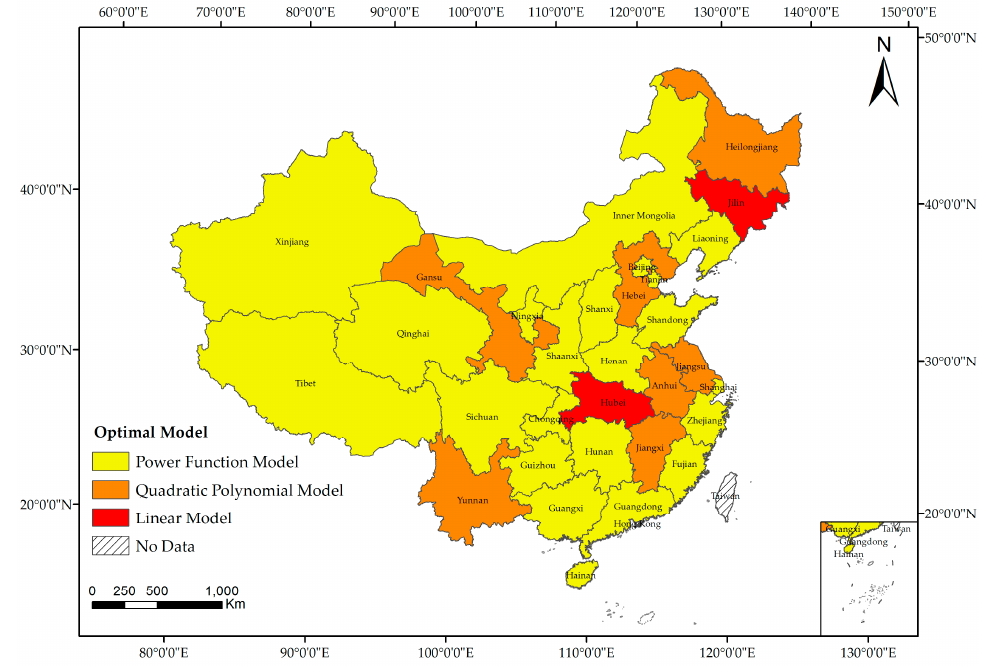
Figure 5. Spatial distribution of optimal models of the relationship between the statistical GDP data and TNL at the provincial level.